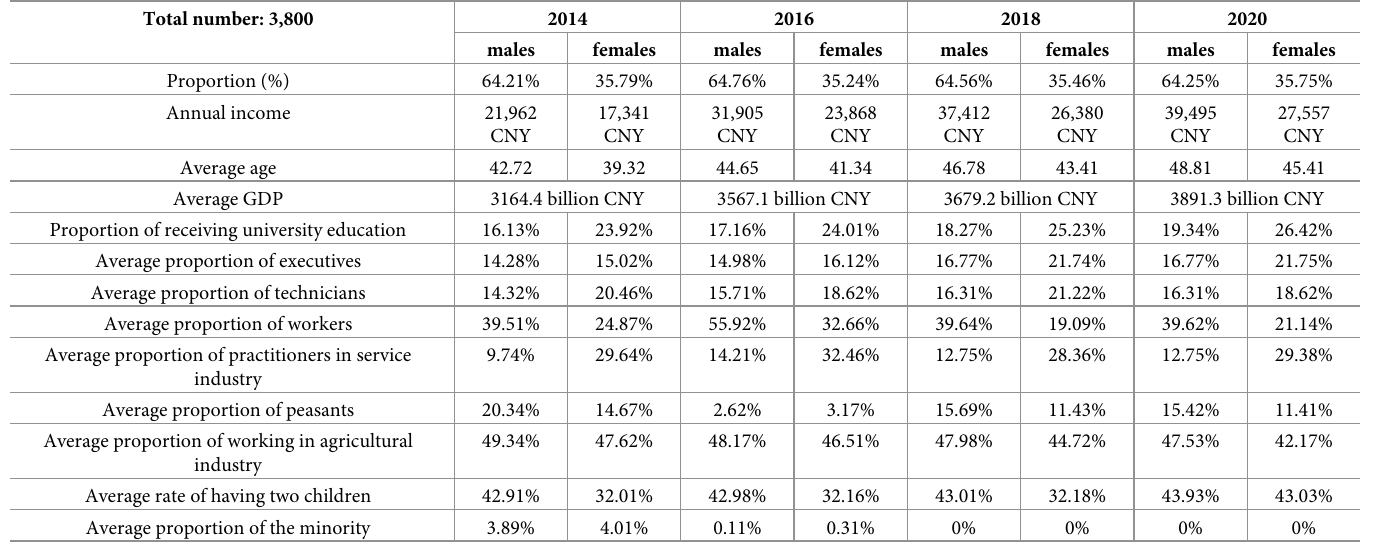
Table 3. Principal data of